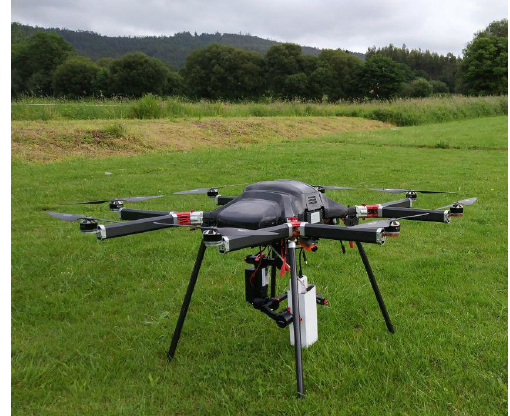
Figure 4. A UAV like the one used in this